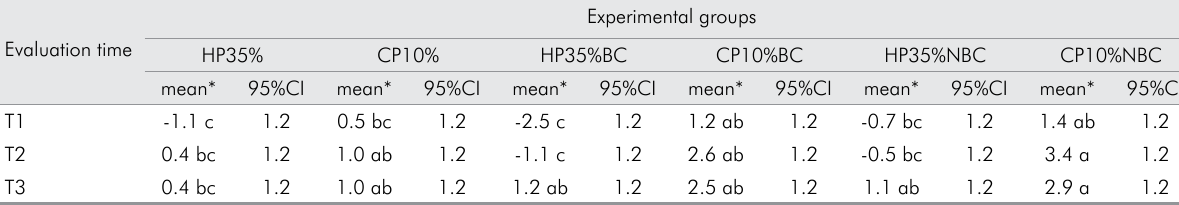
*Different letters means significant differences (p < 0.05).